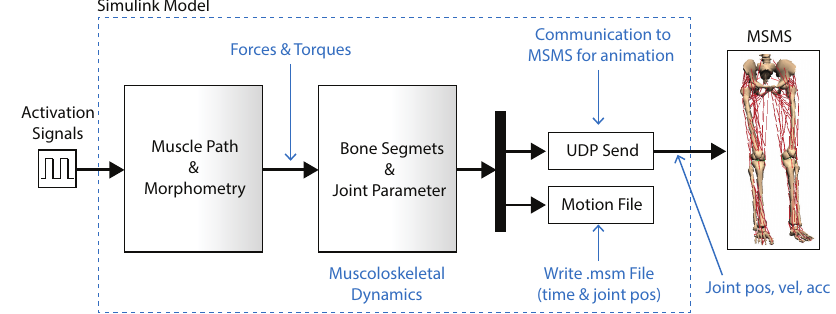
Figure 7. Simulink block model and MSMS integration.